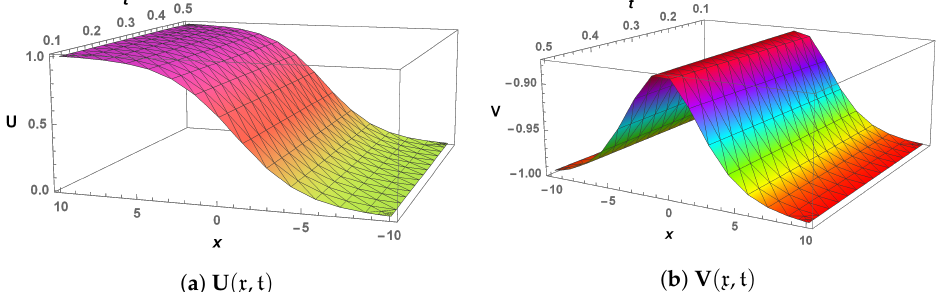
Figure 4. Three-dimensional (3D) plot of LHPM solution in Example 2 when β = 1 and η = a = 0.5.